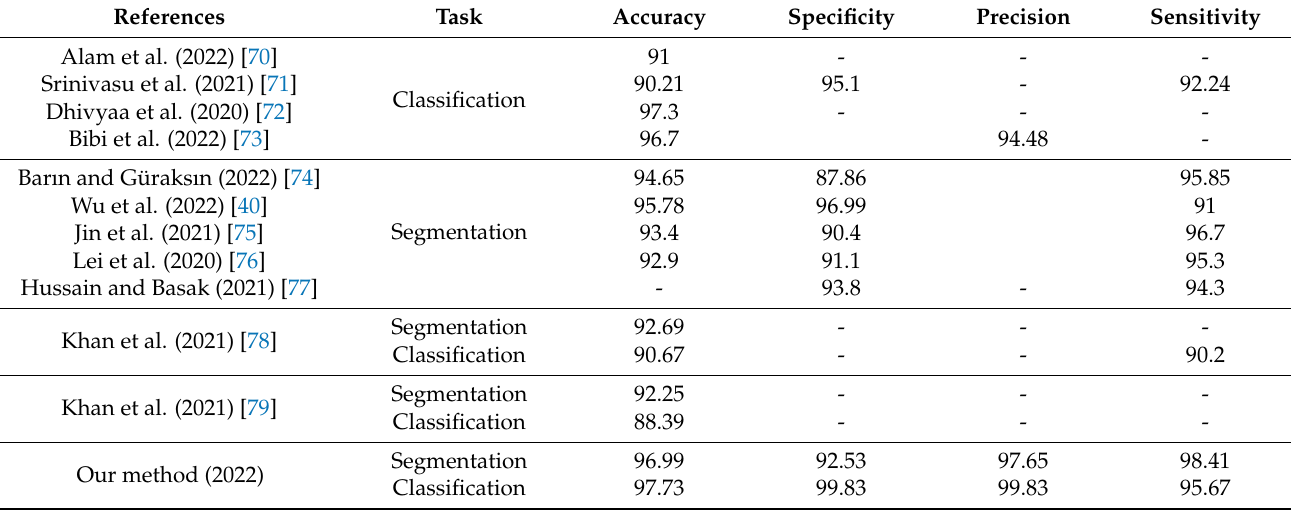
Table 5. Comparison of the proposed model’s segmentation and classification results (%) with previous studies.